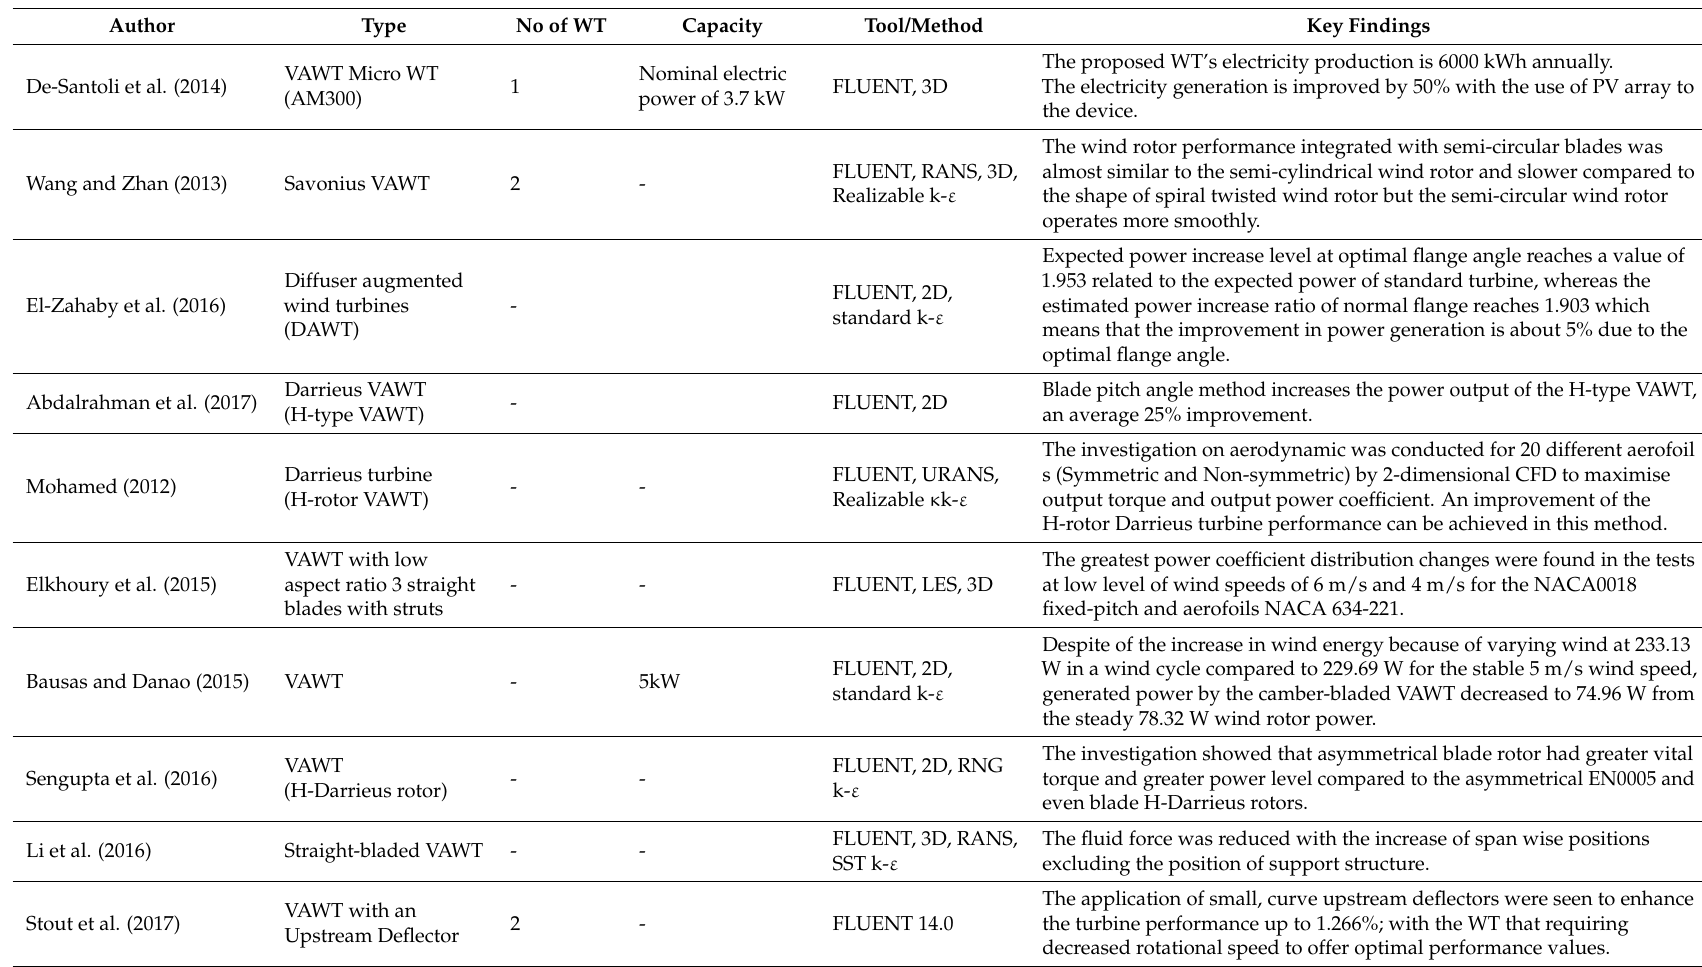
Table 1. Wind Turbine Assessment—Small Wind